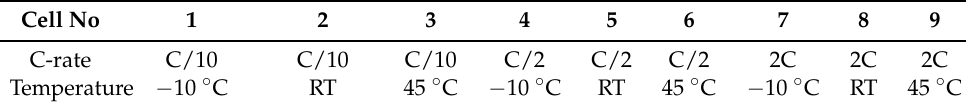
Table 1. GITT experimental